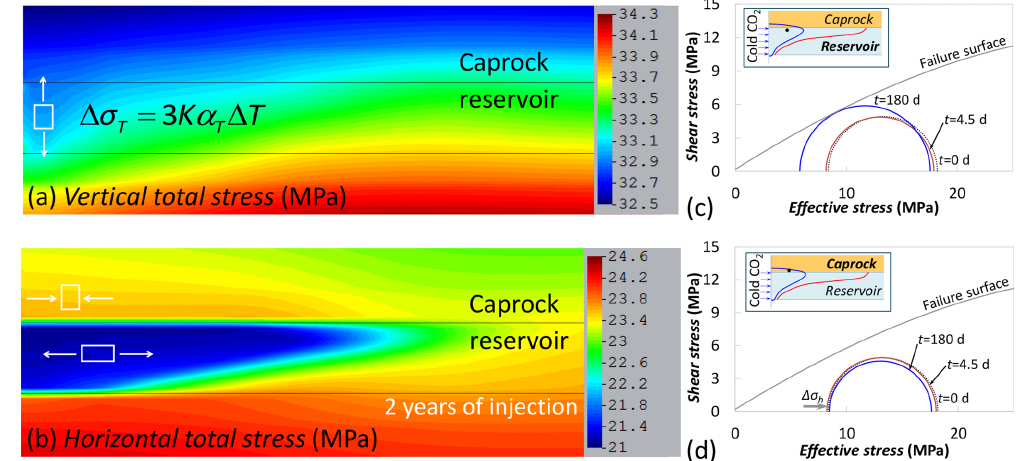
Figure 5. Total stresses in the (a) vertical and (b) horizontal direction after 2 years of injecting 0.2Mtyr − 1 of CO 2 at 20 ◦ C through a vertical well, indicating the sign of the induced stresses. Thermal stresses, (cid:49)σ T , are proportional to the bulk modulus, K ; the thermal expansion coefficient, α T ; and the temperature difference, (cid:49)T . The changes in the Mohr circles at a point placed 25m away from the injection well in (c) the reservoir (2m below the reservoir–caprock interface) and (d) the caprock (2m above the reservoir–caprock interface) are also